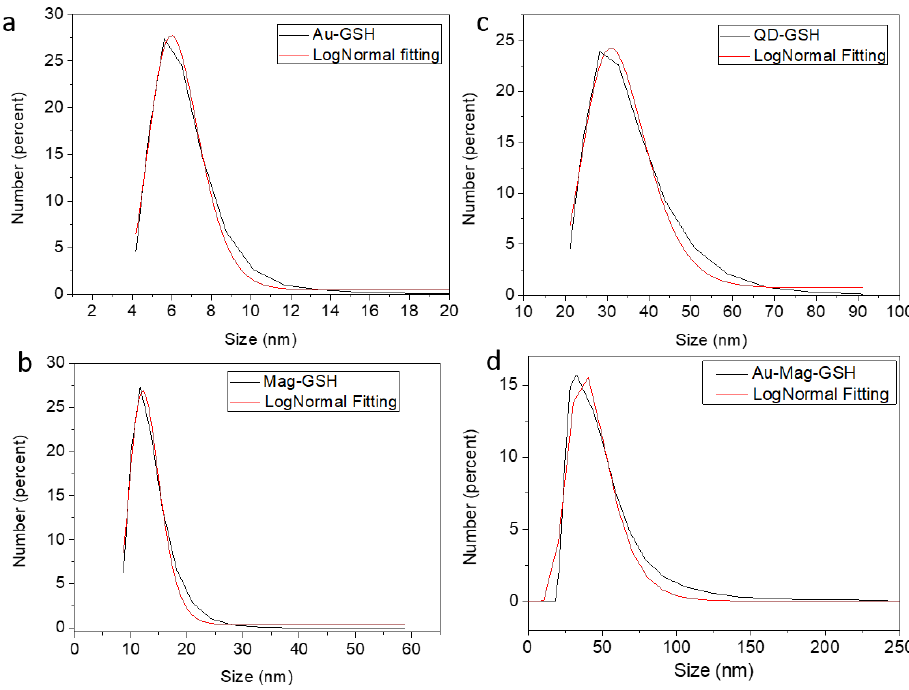
Figure 7. DLS size distributions of Au-GSH ( a ), Mag-GSH ( b ), CdTe-GSH1 ( c ) and Au-Mag-GSH ( d ) in PBS (phosphate-buffered saline) colloidal solutions.